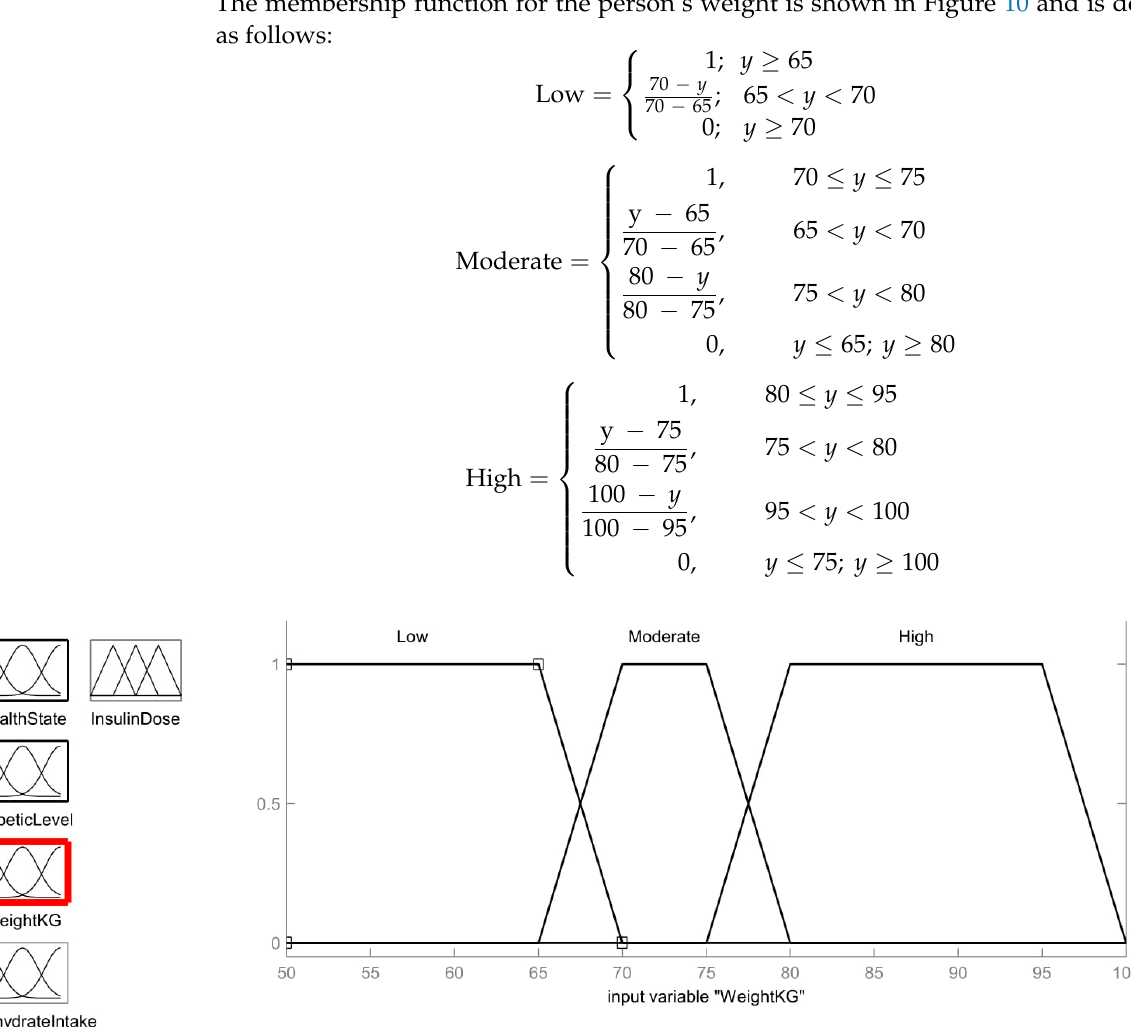
Figure 10. Patient’s Weight Membership function.